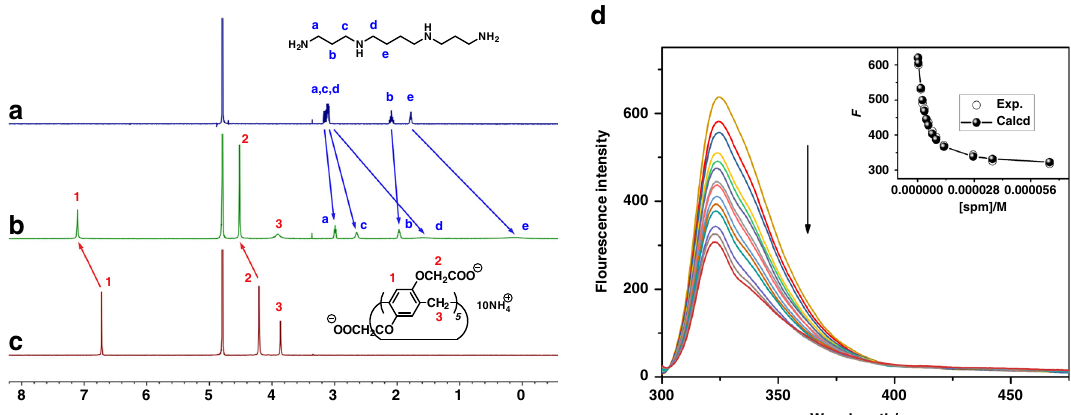
Fig. 2 Host – guest complexation studies. 1 H NMR spectra (500 MHz, 298 K, D 2 O) of a spm (3.0 mM), b spm (3.0 mM) + CP5A (3.0 mM) and c CP5A (3.0 mM); d fl uorescence spectra of P1P5A (2.46 × 10 − 6 M) in aqueous PBS (pH 7.4) with different concentrations of spm at 298 K, inset: the nonlinear